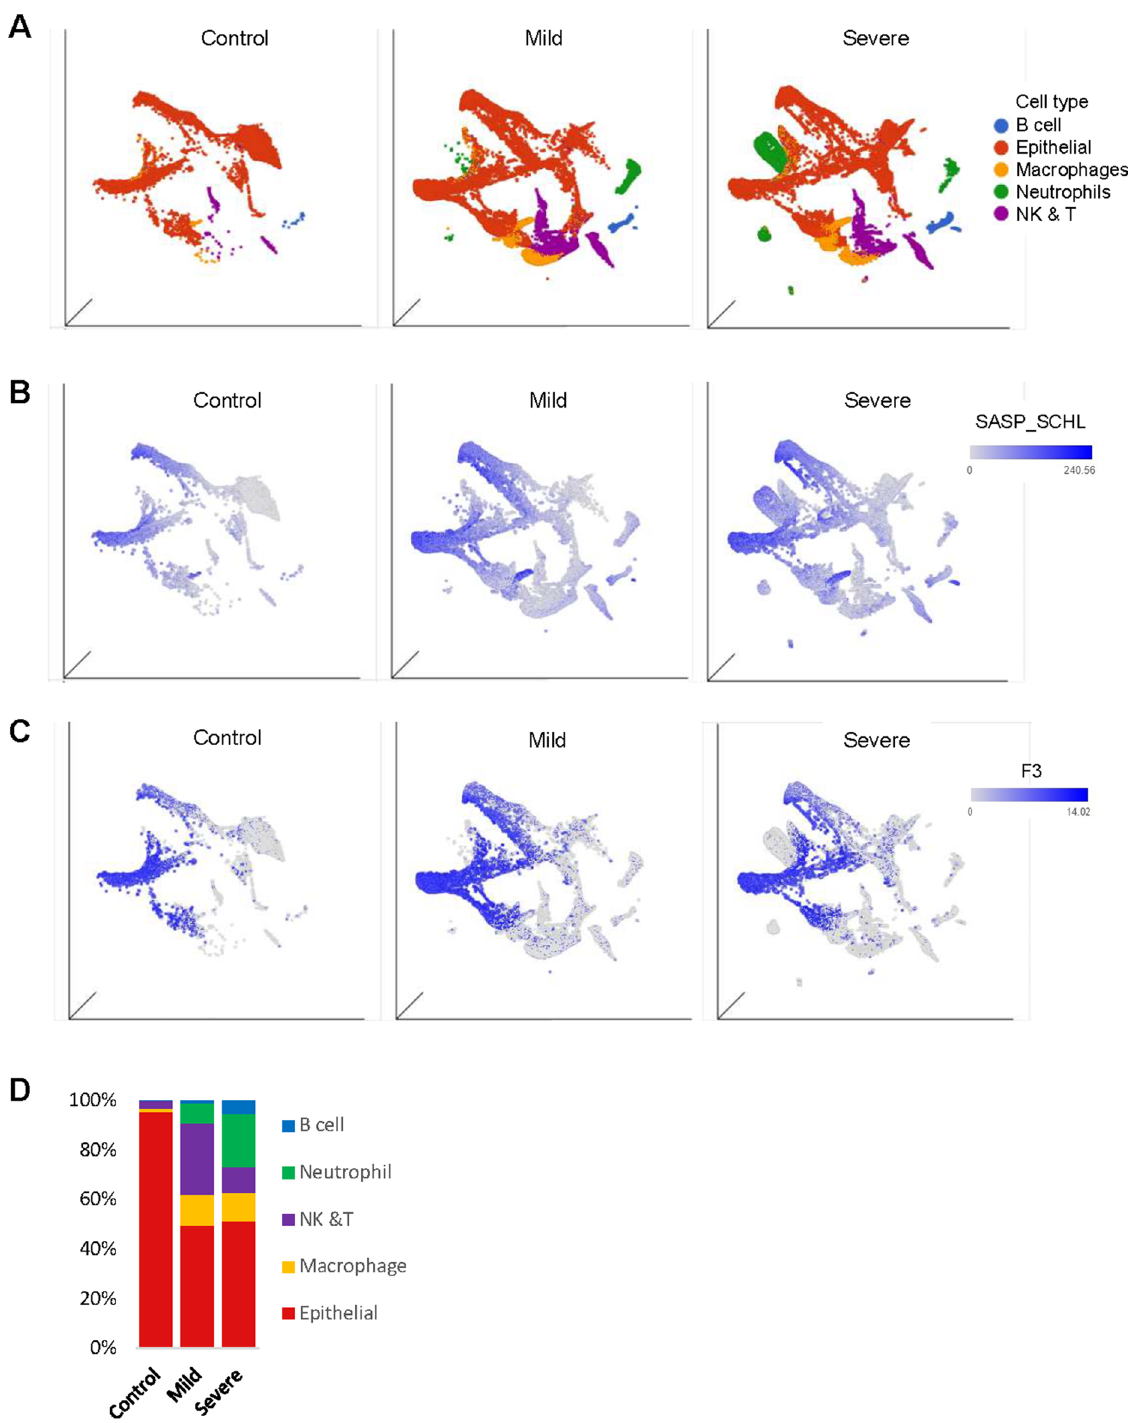
Figure 4. F3 and SASP factor genes are highly expressed in nasopharyngeal (NS) cell population from the COVID-19 patients. ( A ) UMAP projection of the major cell types in NS of COVID-19 patients (control, n = 5; mild, n = 8; severe, n = 11). Cell type composition in NS was quantitated in ( D ). ( B , C ) UMAP plot of NS cells derived from healthy control and COVID-19 patients. SASP factor expression level ( B ) and F3 level ( C ) of each cell are marked with blue